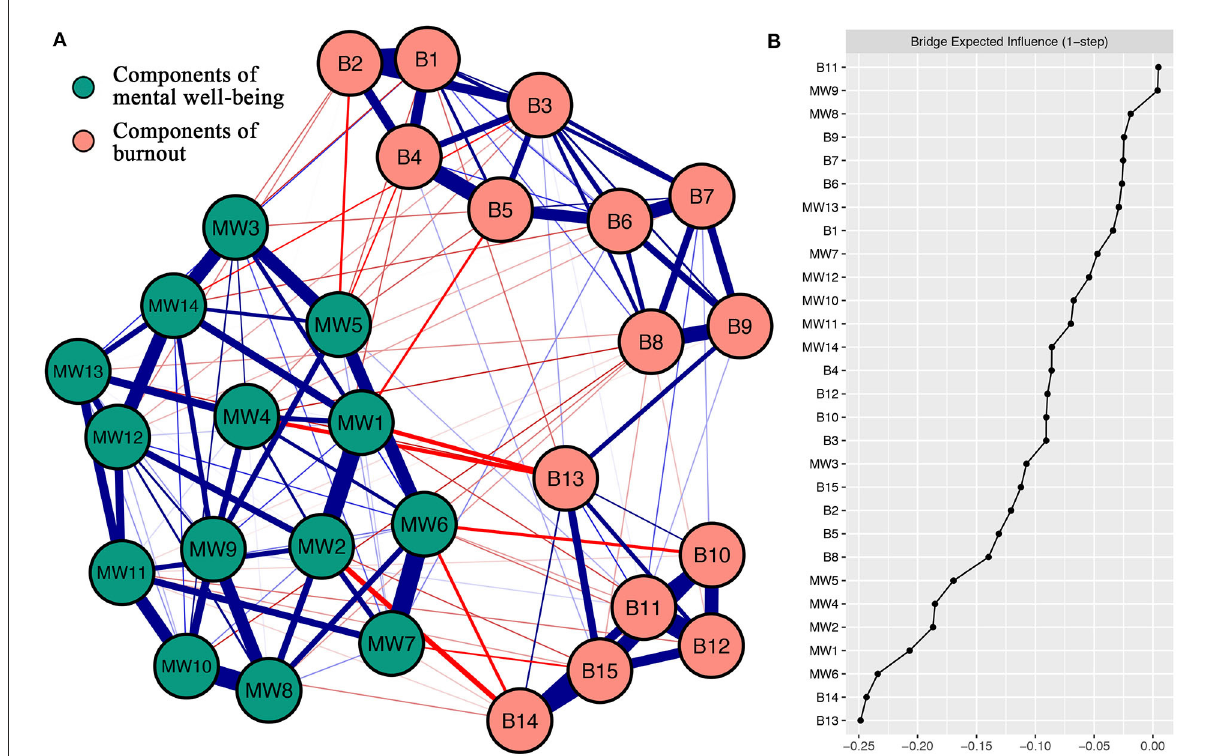
FIGURE1 (A) Network construction of different components of mental well-being and burnout. Blue edges delegate positive correlations, and red edges delegate negative correlations. The magnitude of the correlation was reflected by the thickness of the edge. Cut value = 0.05. (B) Centrality plot drawing the bridge expected influence of per variable selected in the present network (raw score). The text of components of mental well-being and burnout can be seen in Table